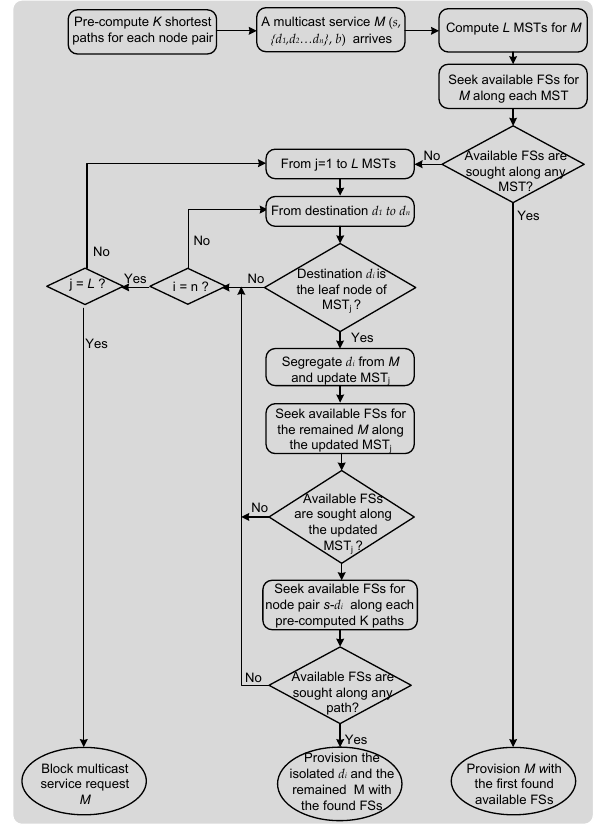
Figure 2. Flow chart of the proposed PFS MRSA algorithm.